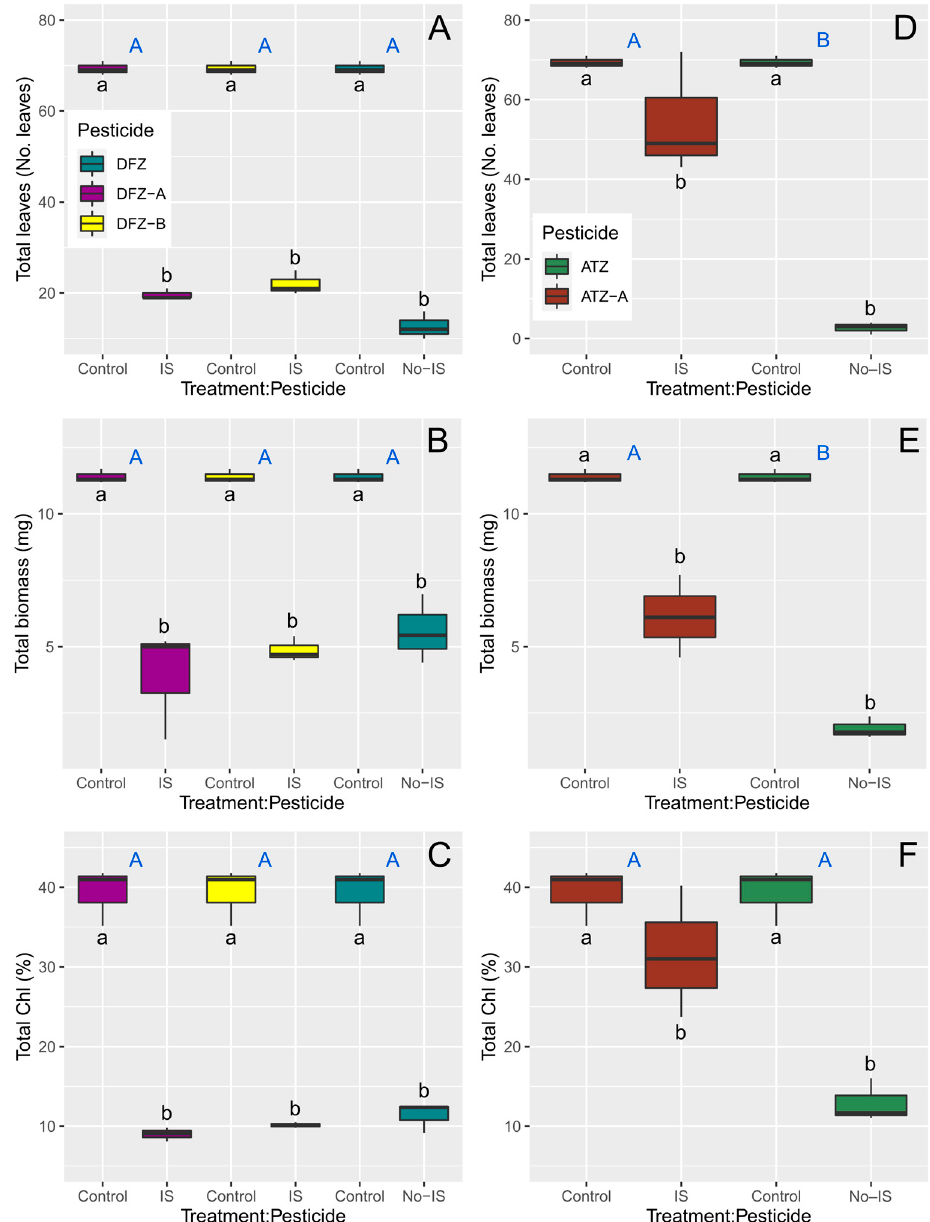
Figure 2. Effects of difenoconazole ( A – C ) and atrazine ( D – F ) and their photodegradation products after seven days of exposure on the number of leaves, biomass, and total chlorophyll (Chl) content of L. minor . Control refers to a concentration of 0 mg/L, whereas IS (irradiated solution) refers to highest concentration used in the bioassays, i.e., 8 mg/L for difenoconazole and its photodegradation products, and 3.84 mg/L for atrazine and its photodegradation product. Different letters denote significant differences in the means at p ≤ 0.05 (pairwise comparisons) between different treatment (blue uppercase letters) and pesticide concentrations (lowercase letters).